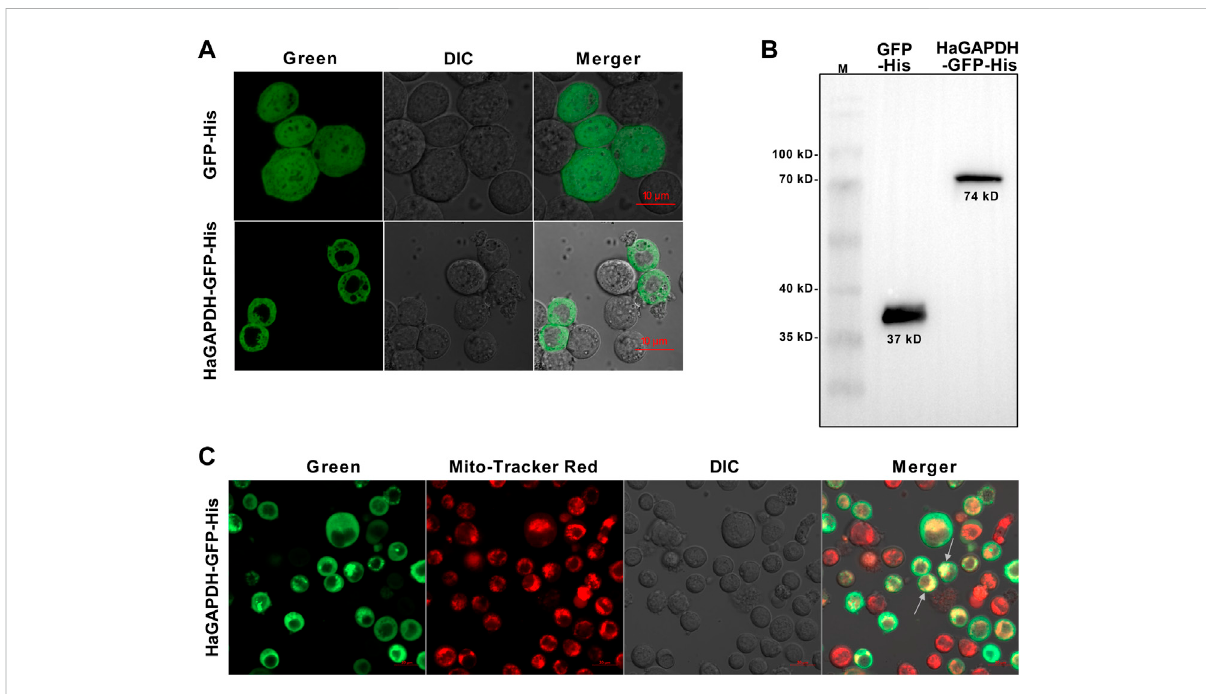
FIGURE 3 Mitochondrial localization of HaGAPDH . (A) Subcellular localization of HaGAPDH -GFP-His in Sf9 cells using an LSM710 confocal microscope. GFP-His was the control. The merger was the overlap of the green and bright fl uorescence. (B) Expression of GFP-His (37 kD) and HaGAPDH -GFP- His (74 kD) in Sf9 cells by Western blot. M: protein marker. (C) HaGAPDH – GFP – His merged with mitochondria. The pictures were taken by using an LSM710microscope. HaGAPDH – GFP – HisoverexpressioncellsweredyedwithMito-Tracker(50 nM)for15 min.Themergerwastheoverlapof the green fl uorescence, Mito-Tracker red, and